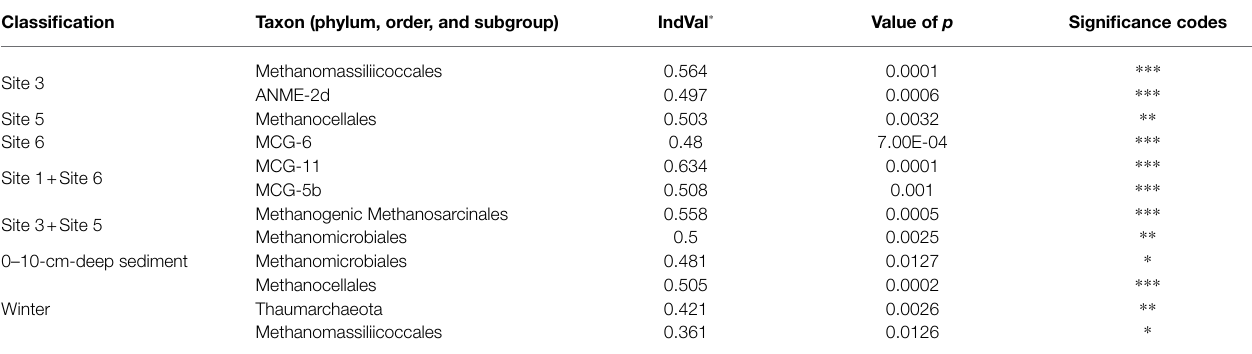
TABLE 1 | Differentially abundant archaeal orders, subgroups, and phyla (relative abundance ≥ 1%) associated with selected classification groups based on an indicator species analysis.